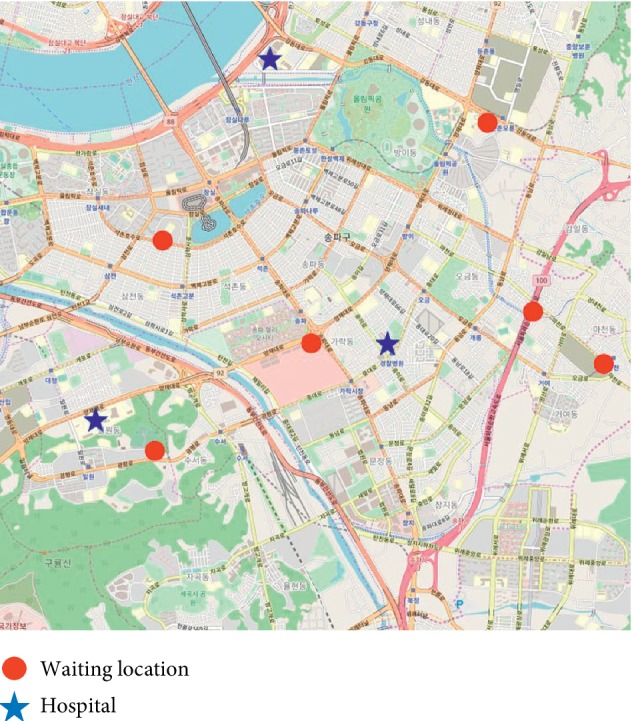
Locations of emergency centers and hospitals in Songpa-gu, Seoul.